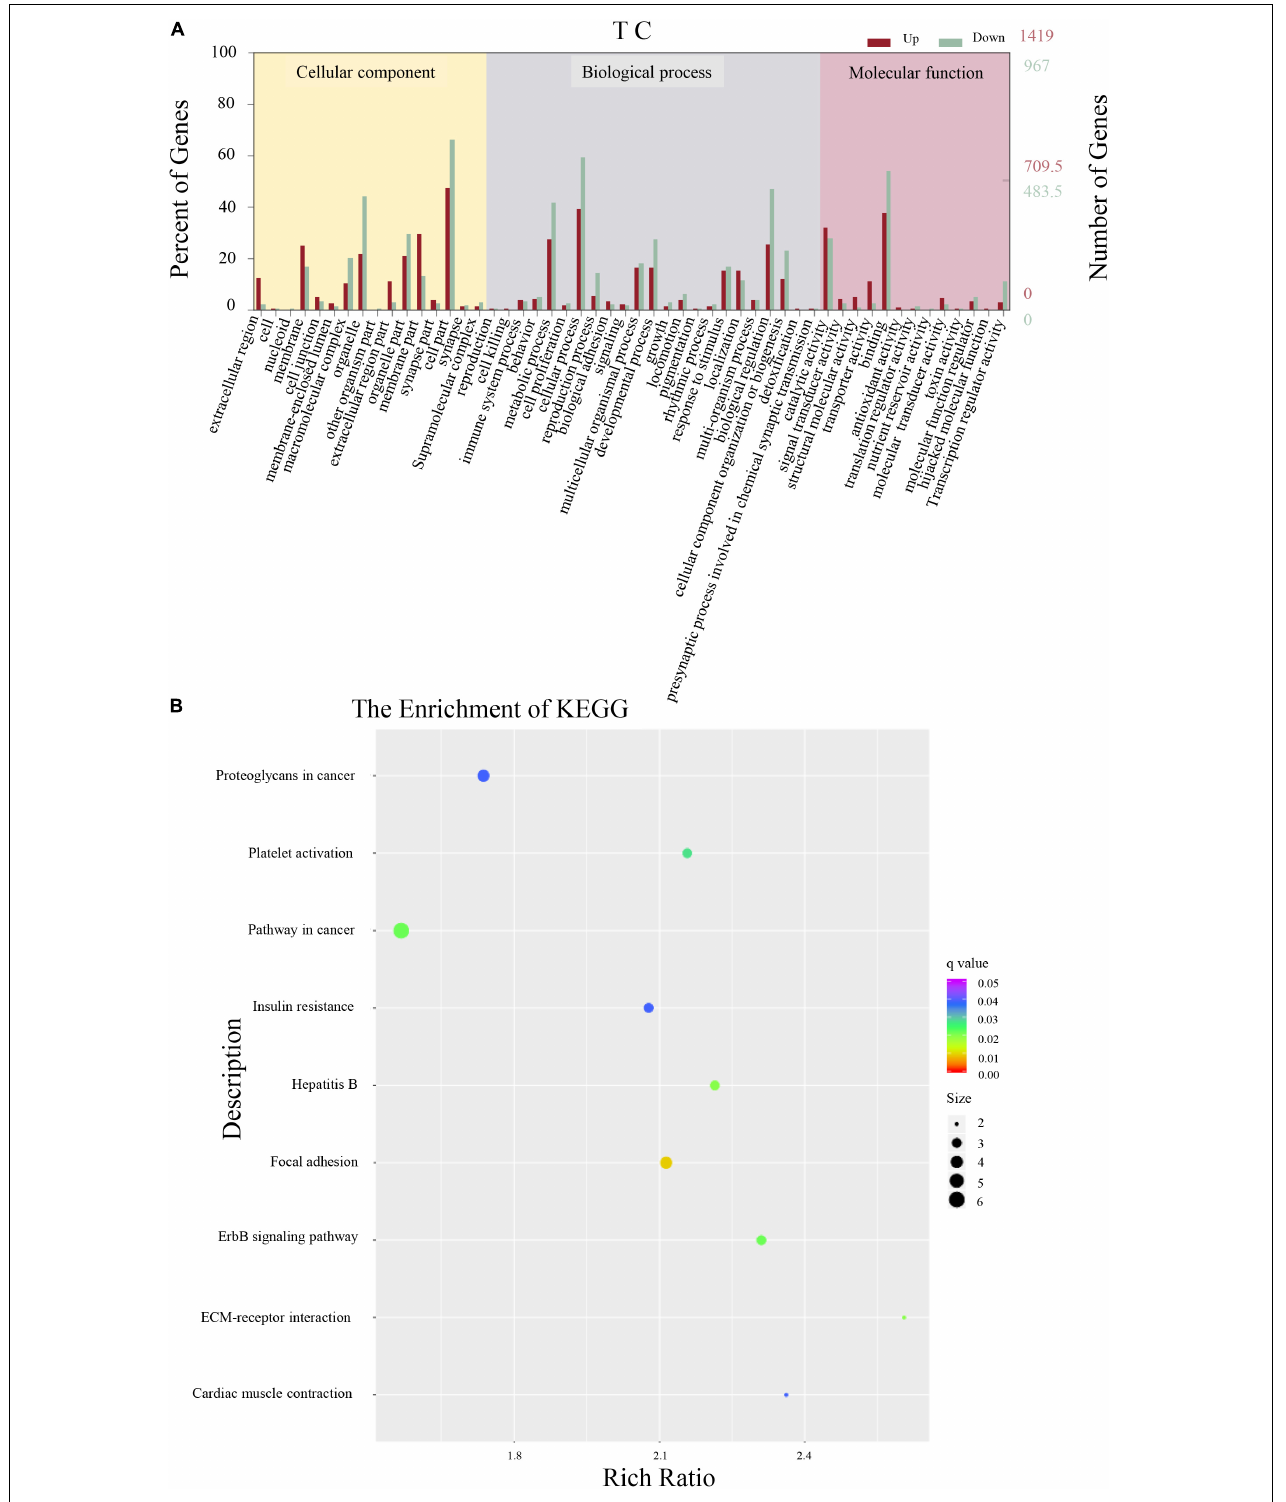
FIGURE 2 | Differentially expressed gene analysis of adult whole-body samples. (A) Annotated statistical graph of the Gene Ontology (GO) secondary nodes. Light colors represent all genes and dark colors represent all differentially expressed genes (DEGs) of Bactrocera dorsalis adults. (B) Scatter plot of enriched KEGG pathways. Each circle in the graph represents the number of genes enriched for a specific KEGG pathway. Enrichment factors represent the ratio of the number of differentially expressed genes to all the genes in the pathway.